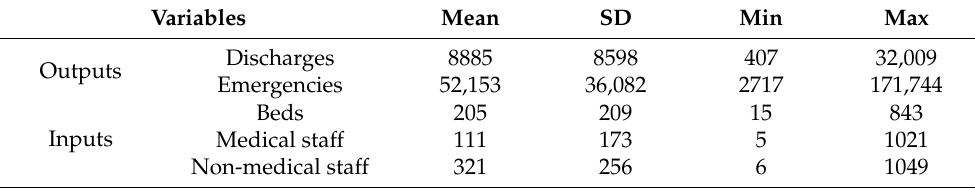
Table 2. Descriptive statistics for the pooled sample with all